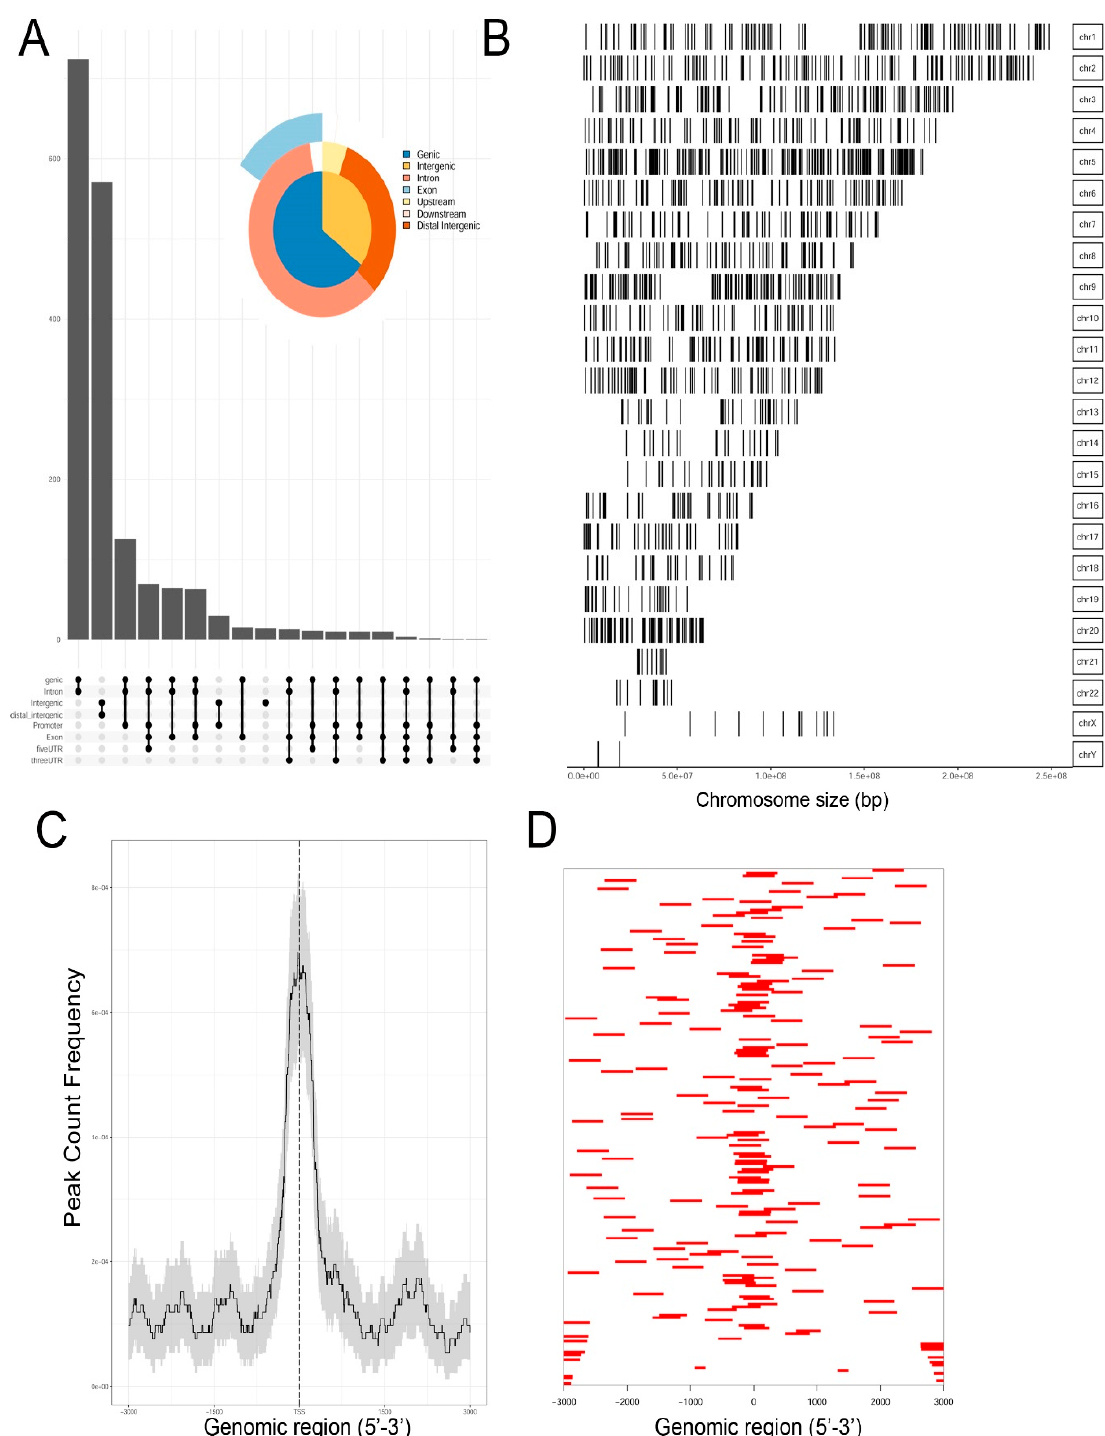
Figure 6. Analysis of RSV-induced open chromatin domains. ( A ) Upset plot of genomic annotations of ATAC-Seq peaks. Note the highest frequency of sites corresponds to intronic locations in gene bodies. ( B ) Genome coverage of open chromatin domains each chromosome (at right). ( C ) Distribution of peaks relative to the transcription start site (TSS). ( D ) tagged heat map of open chromatin domains relative to the 5 (cid:48) regulatory region from − 3000 nt to + 3000 nt. Each red bar represents the length of open chromatin domain on a